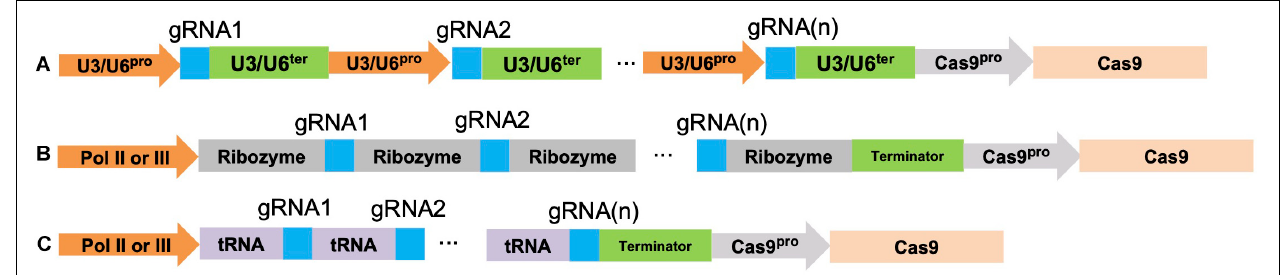
FIGURE 2 | Three CRISPR/Cas9 multiplexing approaches. (A) Multiple gRNA(s) can be assembled together as multiple transcription cassettes. Either a U3 or U6 promoter/terminator is used depending on the monocot or dicot species being targeted. (B) CRISPR/Cas9 multiplexing is done by spacing a ribozyme sequence before and after each gRNA sequence; these ribozyme-gRNA-ribozyme (RGR) units undergo self-cleavage after transcription. (C) The polycistronic tRNA-gRNA (PTG) system fuses each gRNA with a tRNA sequence, endogenous RNaseP and RNaseZ can recognize, cleave at the tRNA sequence, and release the gRNA after transcription. The blue color indicates different gRNA sequences. Each gRNA multiplexing gene construct also contains a Cas9 gene under the control of a specific promoter such as the actin, ubiquitin, 35S, and the germline cell